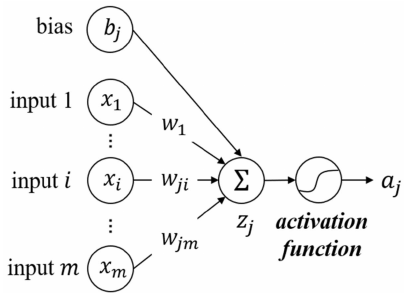
Figure 5. Process of a single neuron in